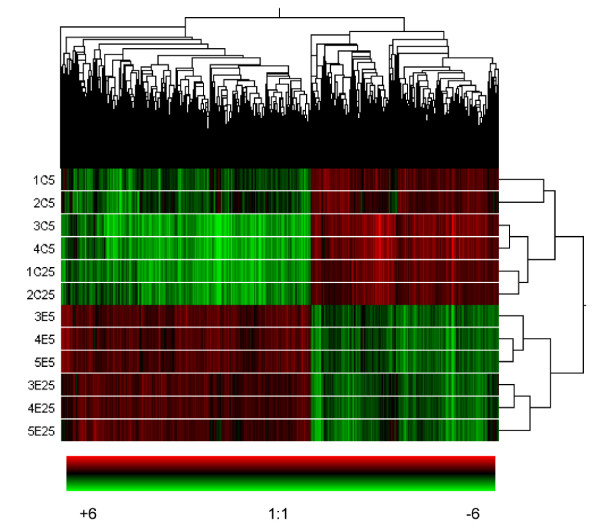
Gene expression response to low-shear modeled microgravity. Two-dimensional hierarchical cluster heat map analysis of the microarray transcriptional profile of gene response to low-shear modeled microgravity (LSMMG) in S. cerevisiae wild-type diploid cells (BY4743) grown in HARVs (experimental group) for 5 generations (3E5, 4E5, 5E5) or 25 generations (3E25, 4E25, 5E25) versus the control group grown in HARVs for 5 generations (1C5, 2C5, 3C5, 4C5) or 25 generations (1C25, 2C25). The analysis was performed on 1372 statistically significant genes (from the filtered list of 3850 genes) with a fold change of at least 2 in one of three comparisons as described in Methods. Levels of expression are indicated on a color scale where red represents the up-regulated genes and green, the down-regulated genes. Similarities or differences in the experimental versus control gene expression patterns are represented in the horizontal dendrogram. The vertical dendrogram shows similarities in expression patterns between cultures exposed to LSMMG versus control cultures.